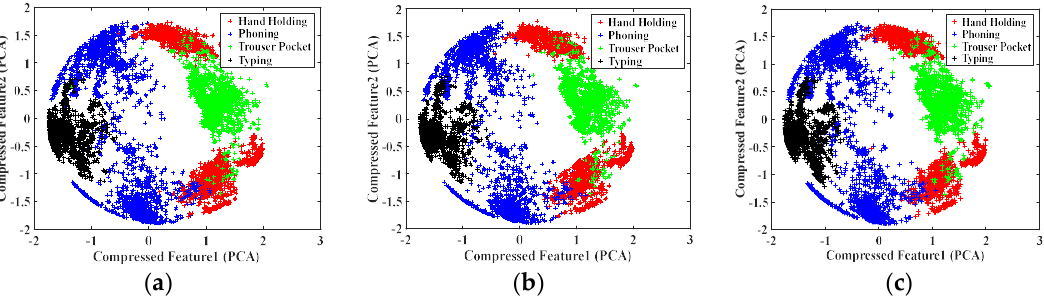
Figure 8. Distribution of compressed features of human poses with different window lengths: ( a ) 1 s; ( b ) 2 s; and ( c ) 3 s.